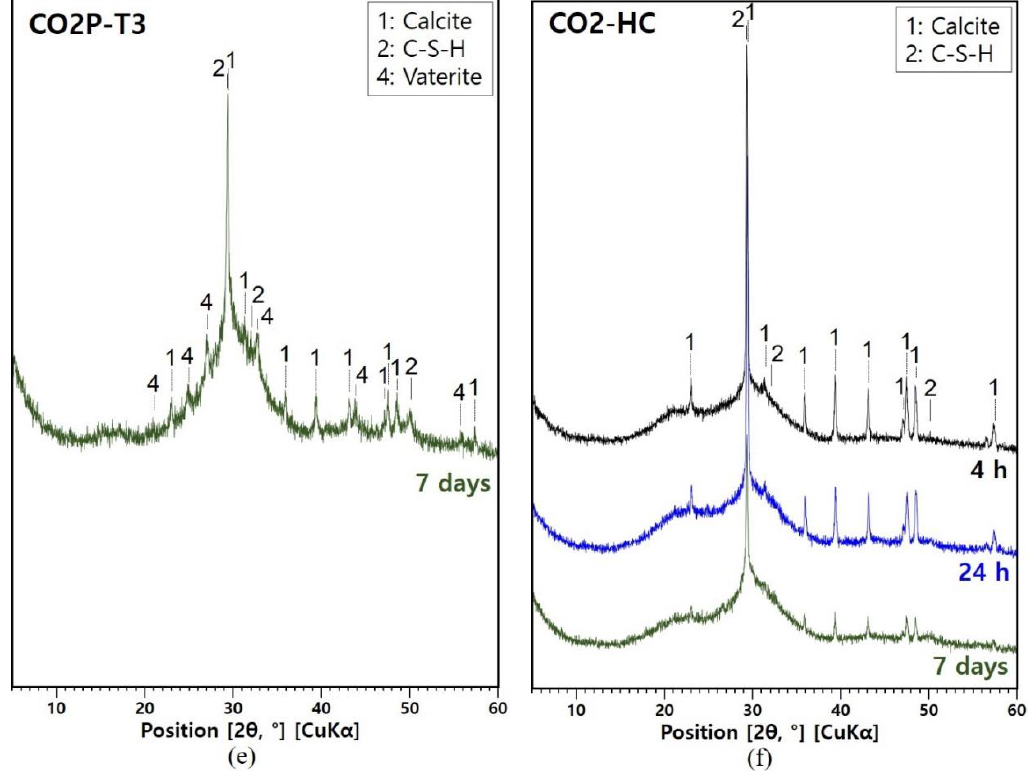
Figure 5. XRD patterns of samples with curing time. ( a ) Control; ( b ) detailed XRD figure of the control sample in the 29 –30° 2θ range with reference patterns of calcite and calcium silicate hydrate (C-S-H); ( c ) CO2P-T1; ( d ) CO2P-T2; ( e ) CO2P-T3; ( f ) CO2-HC. 1: calcite (PDF 98-005-2151), 2: C-S-H (PDF 00-033-0306), 3: C-S-H(I) (PDF 00-029-0331), and 4: vaterite (PDF 98-018-1959).